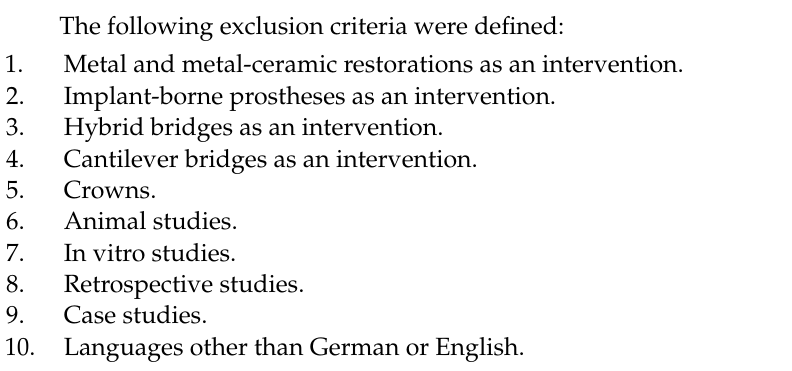
Figure 1. Search strategy.